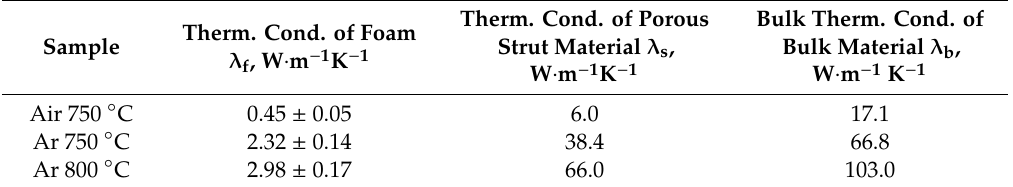
Table 4. Thermal conductivity of aluminum foams thermally processed at 750 °C in air and in Ar at 750–800 °C.